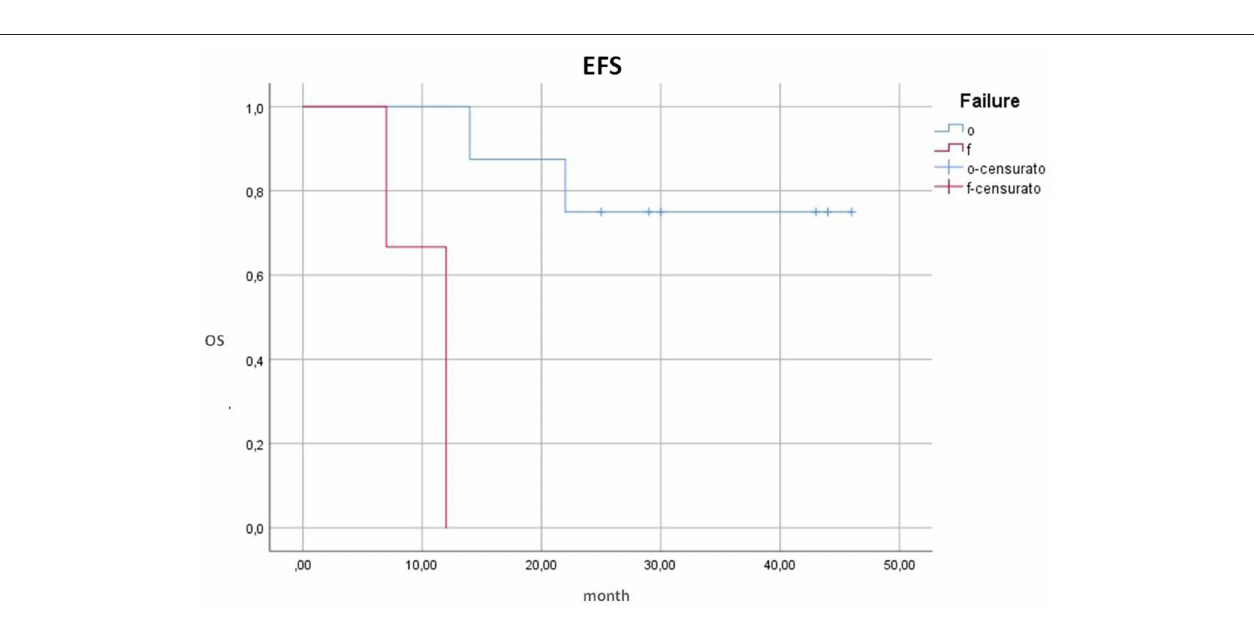
IL10RA, FCER2, and IL2RA, whereas the genes that weighed on the second component were: SMAD3, IL6ST, and FCR2. We also found that other two genes (FCR2 and IL2RA) characterized the third component. In this analysis, the latent values were: 1.7, 1.1, and